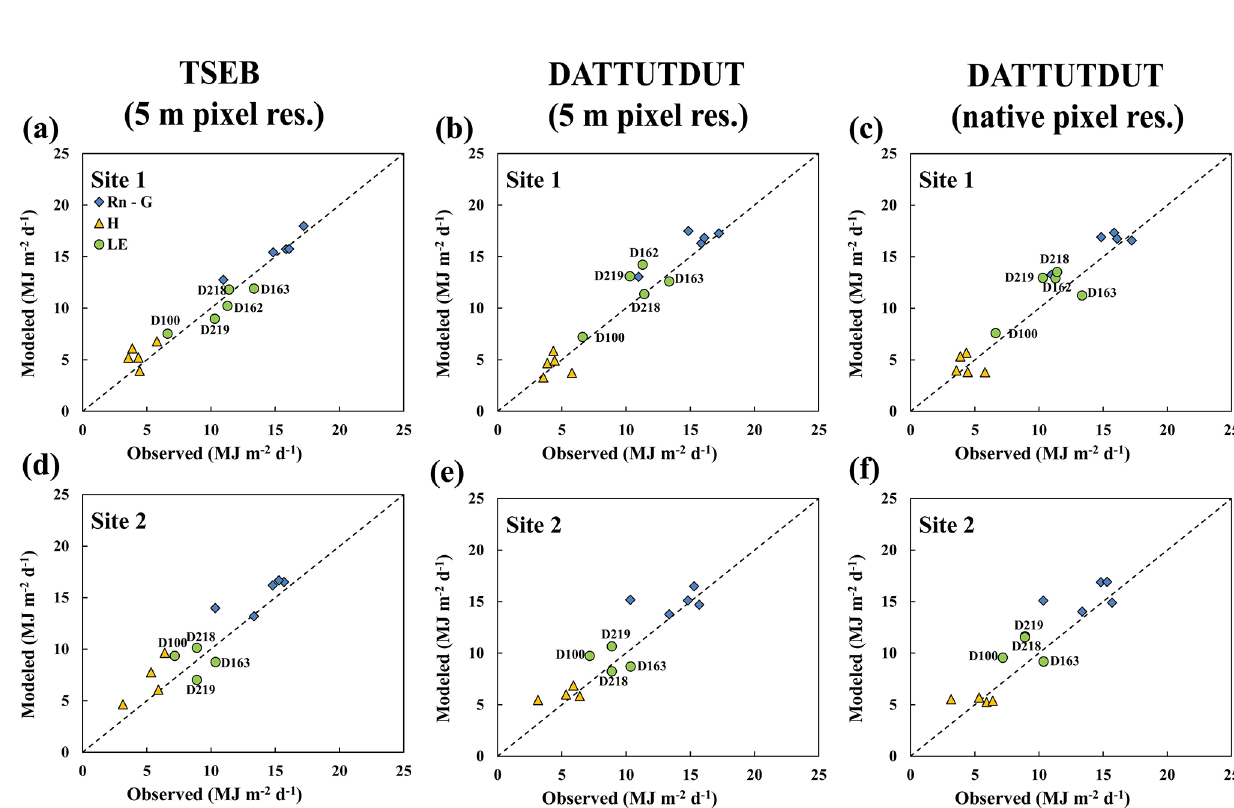
Figure 7. Scatter plots of observed and modeled daytime fluxes from (a) TSEB (5m pixel resolution), (b) DATTUTDUT (5m pixel resolu- tion) and (c) DATTUTDUT (native pixel resolution) for the 5 days in 2013. The observed energy components are adjusted for energy balance using the RE